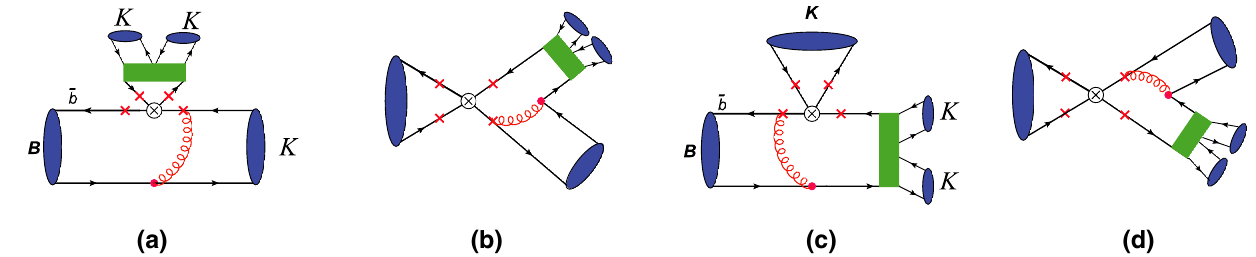
Fig. 1 Typical Feynman diagrams for the quasi-two-body decays B → K R → K K K in PQCD, in which the symbol ⊗ stands for the weak vertex, × denotes possible attachments of hard gluons, and the green rectangle represents intermediate states R